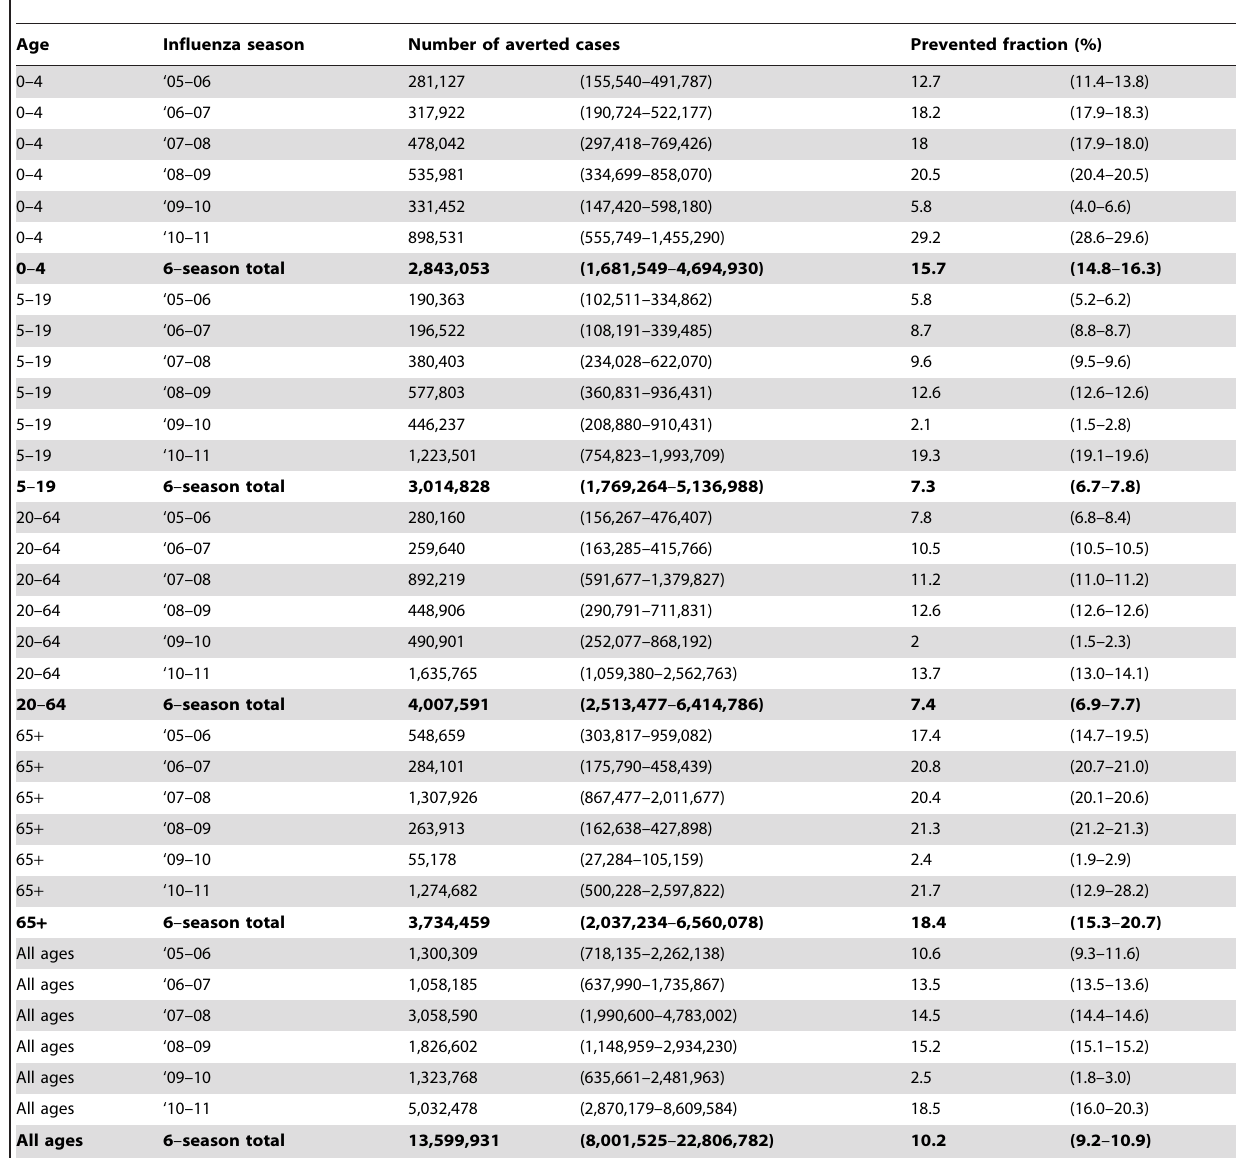
Table 2. Estimated number of influenza cases averted by vaccination and the associated prevented fraction, 2005/06–2010/11 influenza seasons (95% confidence interval in